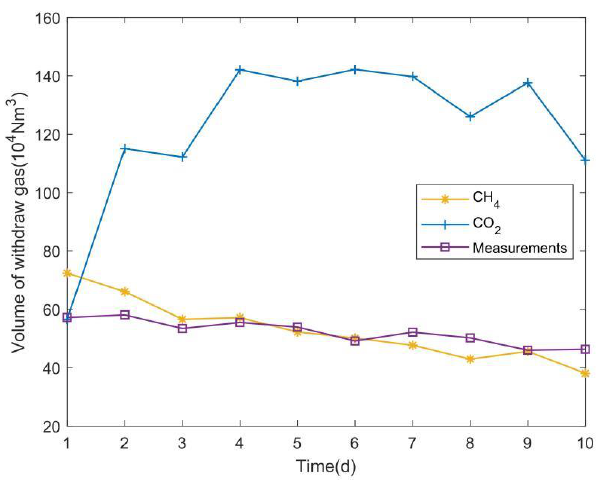
Figure 15. Daily gas withdrawal volume.